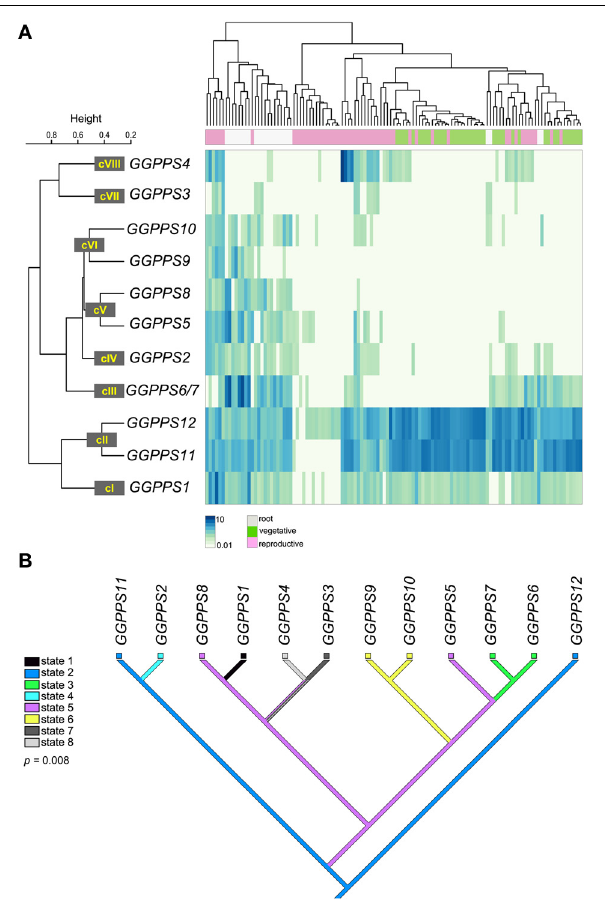
FIGURE 3 | Expression pattern analysis of the GGPPS genes from A. thaliana and ancestral states reconstruction. (A) The clustering of microarray expression data is shown as heatmap. The expression clusters (cI-VIII) of the GGPPS paralogs identified based on Pearson correlation coefficients with a threshold set to r = 0 . 65 (see Materials and Methods) are shown. The various organ and tissue samples were assigned to three major classes: root (white box), vegetative (green box; includes samples from the seedlings, rosette leaves, stems, and cauline leaves) and reproductive (pink box; includes samples from flowers and seeds). (B) The phylogenetic reconstruction of ancestral expression states using parsimony is shown. The colors corresponding to each expression state (state 1–8) are shown in the legend. Colored boxes are shown at terminal branches indicating the observed expression pattern cluster. Branches with multiple colors are associated with several possible expression